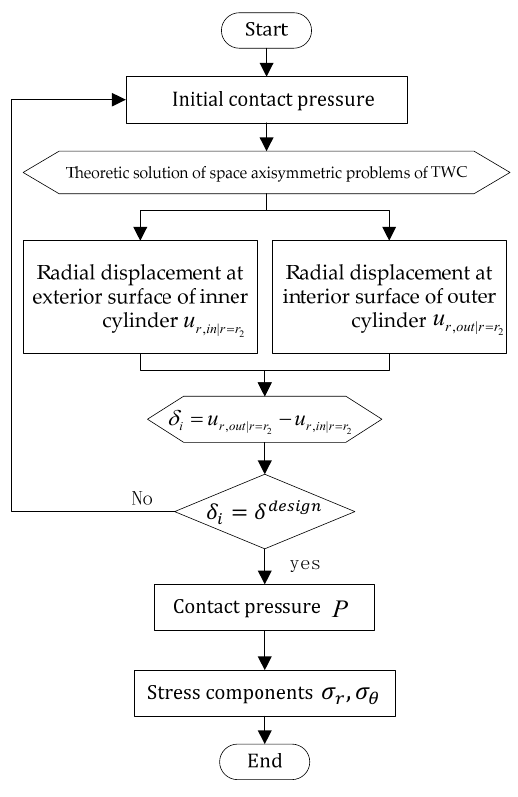
Figure 3. Calculation flow diagram for interference algorithm for BTC. Contact pressure is the key of solving interference problem of bi-layer thick-walled cylinders. With the contact pressure meeting all the constraints, the interior stress of the contact can be derived.